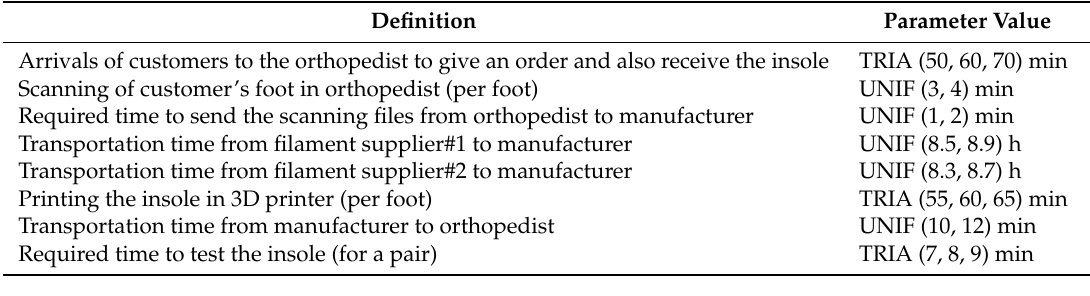
Table 2. Parameters used in 3DPSCN simulation model.